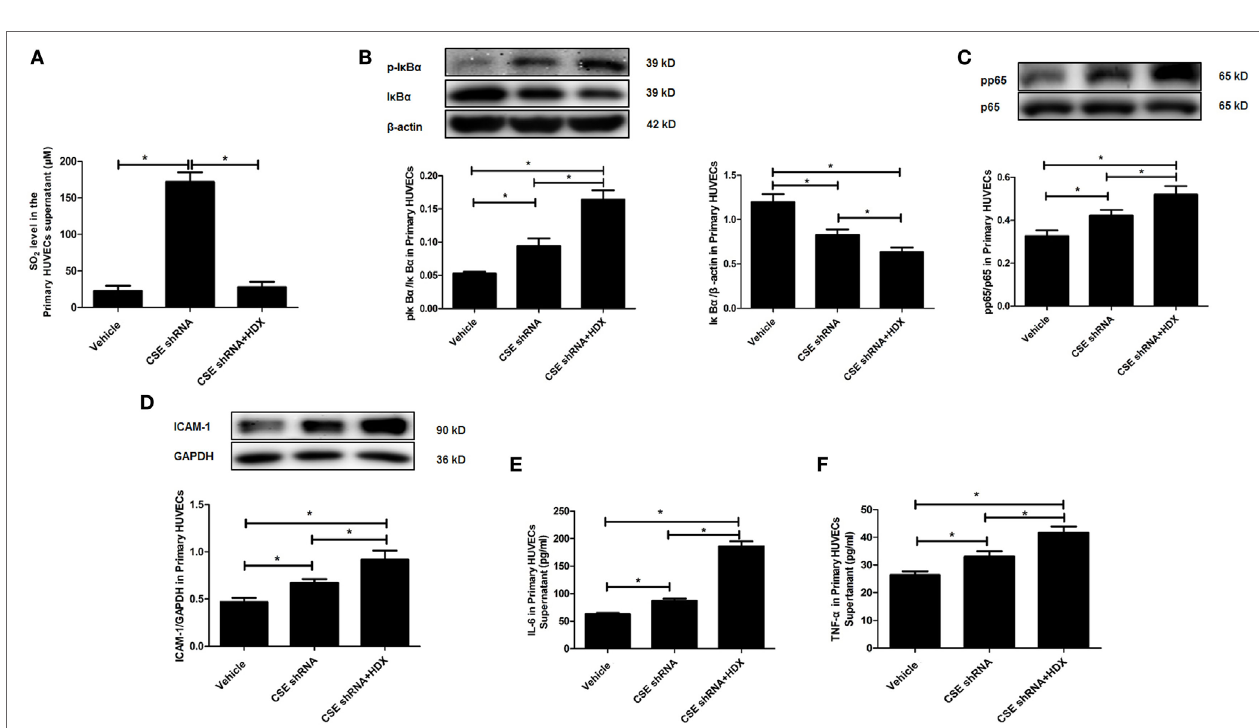
FigUre 6 | Aspartate aminotransferase inhibitor l -aspartate- β -hydroxamate (HDX) aggravated the inflammation caused by cystathionine- γ -lyase (CSE) knockdown in primary human umbilical vein endothelial cells (HUVECs). (a) The SO 2 level in the supernatant of primary HUVECs detected by high-performance liquid chromatography analysis. (B) The phosphorylated and total I κ B α in the primary HUVECs detected by western blot. (c) The phosphorylation of NF- κ B p65 in the primary HUVECs detected by western blot. (D) The expression of ICAM-1 in the primary HUVECs detected by western blot. The levels of IL-6 (e) and TNF- α (F) in the supernatant of the primary HUVECs detected by ELISA. * P < 0.05. Data are expressed as means ± SEM, and all experiments were performed independently for at least three